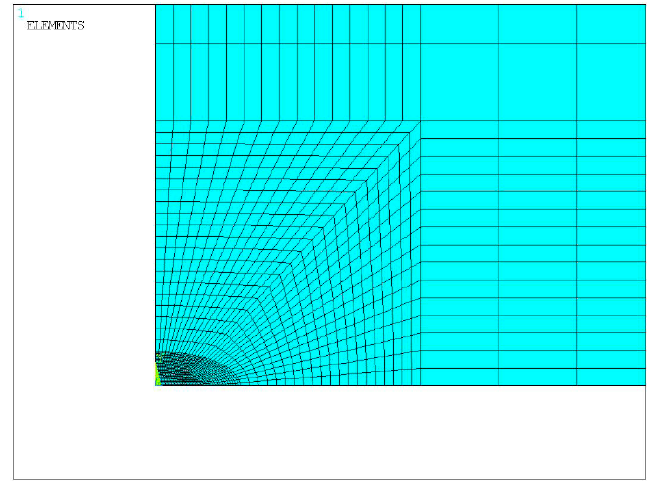
Figure 12. Partial mesh generation of specimen No. 53.